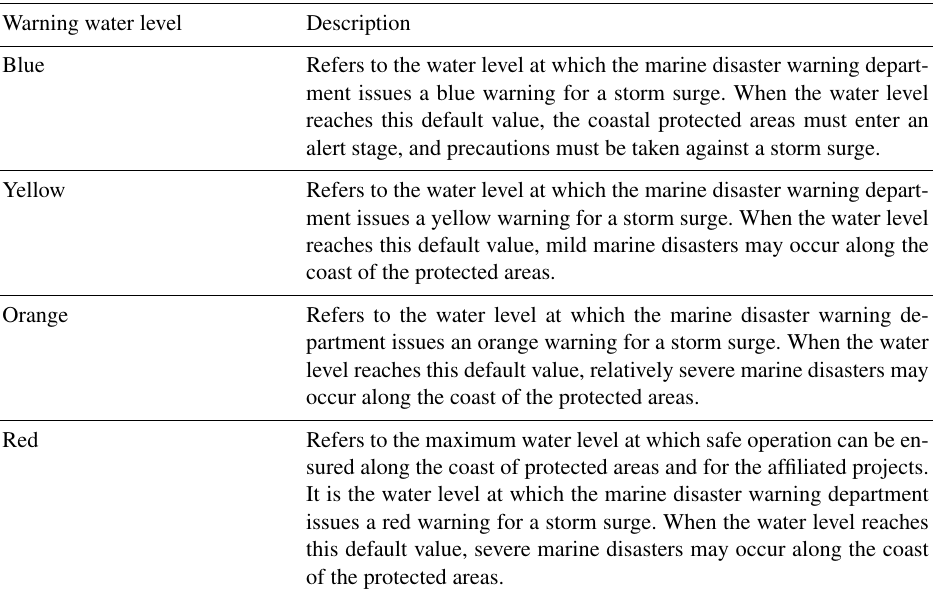
Table 1. Description of the blue, yellow, orange, and red warning water levels. Warning water level